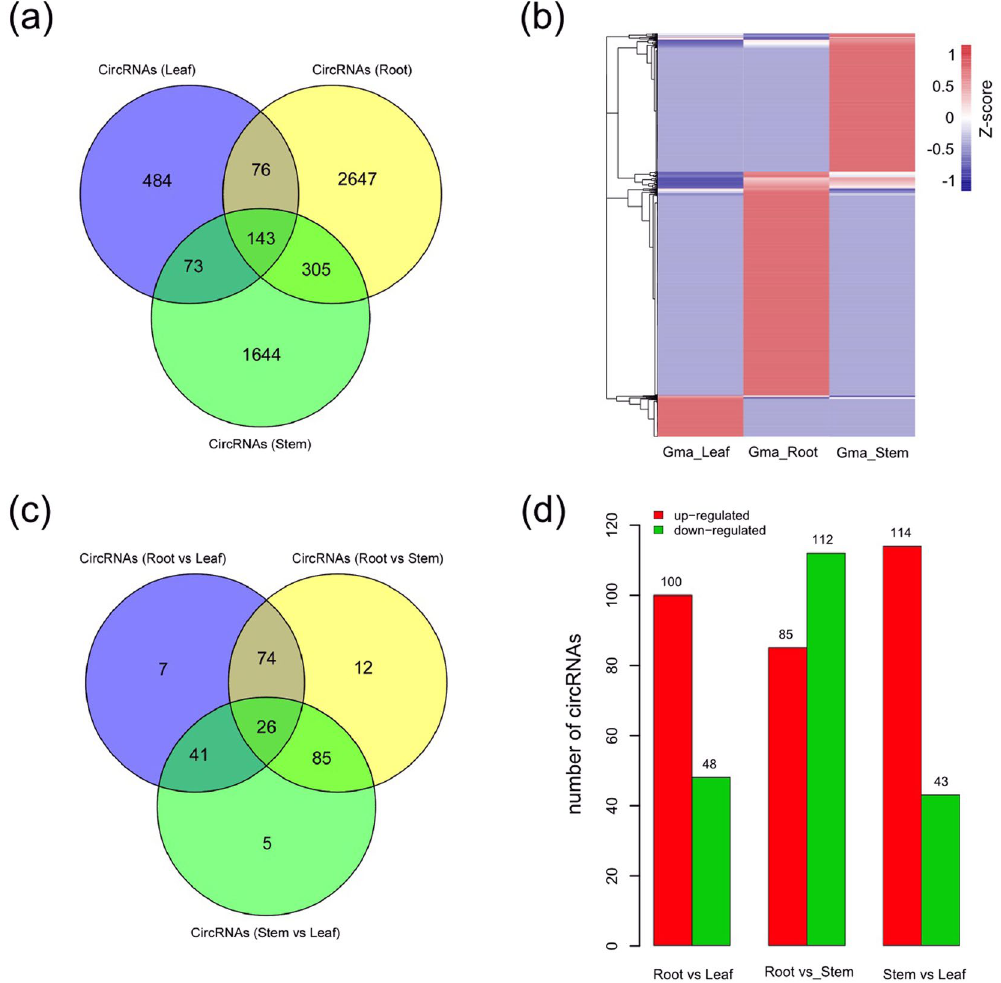
Figure 4. Tissue specific expression patterns of circRNAs in soybean. ( a ) Venn diagram showing the number of tissue-preferentially expressed circRNAs in each tissue of soybean. ( b ) Heatmap showing the expression patterns for all the circRNAs identified in soybean. Vertical columns represented different tissues of soybean. Horizontal rows represented circRNAs. Color scale representing Z-score was given at the left. ( c ) Venn diagram showing the number of differentially expressed circRNAs in each tissue. ( d ) Histogram showing differentially expressed circRNAs among tissues of soybean. The number of up-regulated (red) and down-regulated (green) circRNAs was displayed at the top of each